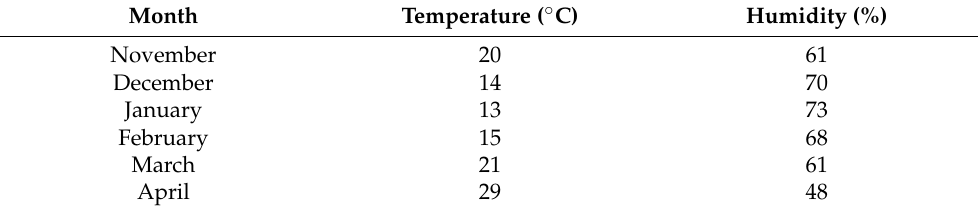
Table 1. Average temperature and humidity during the crop growth period.